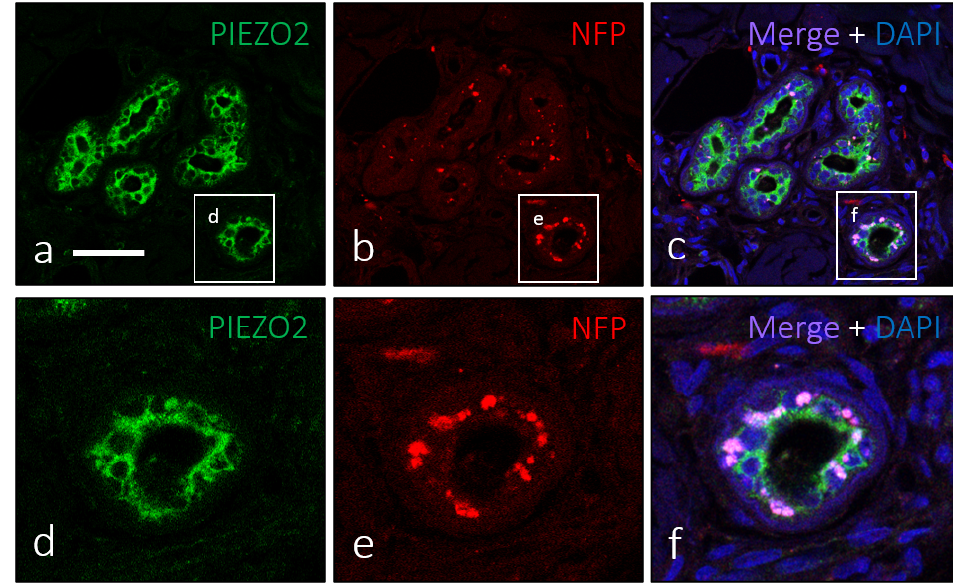
Figure 4. The ductal cells of sweat glands show PIEZO2 immunostaining ( a , d ) and were densely innervated ( b , c , e , f ). Scale bar 100 µm.